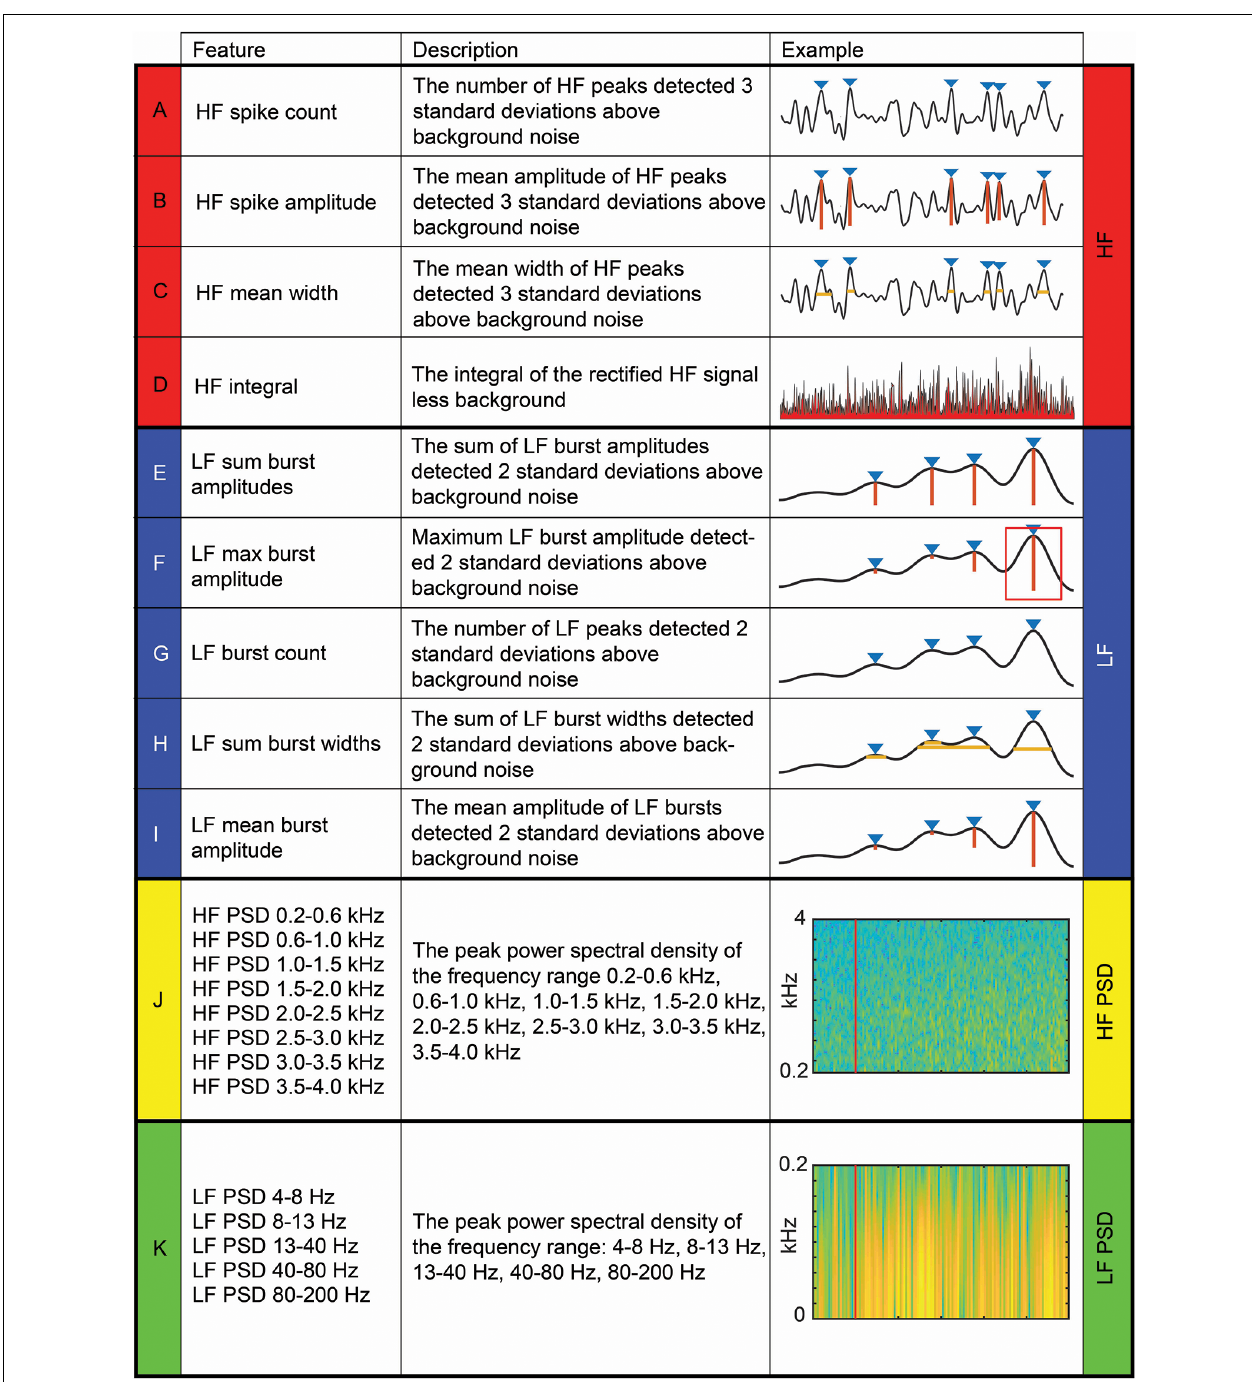
FIGURE 2 | Four categories of 22 dorsal column nuclei signal features extracted for artificial neural network machine-learning. Descriptions and examples of individual features, extracted from dorsal column nuclei signals at various time windows, used to calculate feature-learnability (Loutit et al., 2019) are shown. Individual features were divided into four categories (color-coded): four HF (A–D) ; five LF (E–I) ; eight HF PSD (J) ; and five LF PSD (K) . The red line in (J) and (K) indicates stimulus onset. Abbreviations: HF, high-frequency, LF, low-frequency; HF PSD, high-frequency power spectral density; LF PSD, low-frequency power spectral